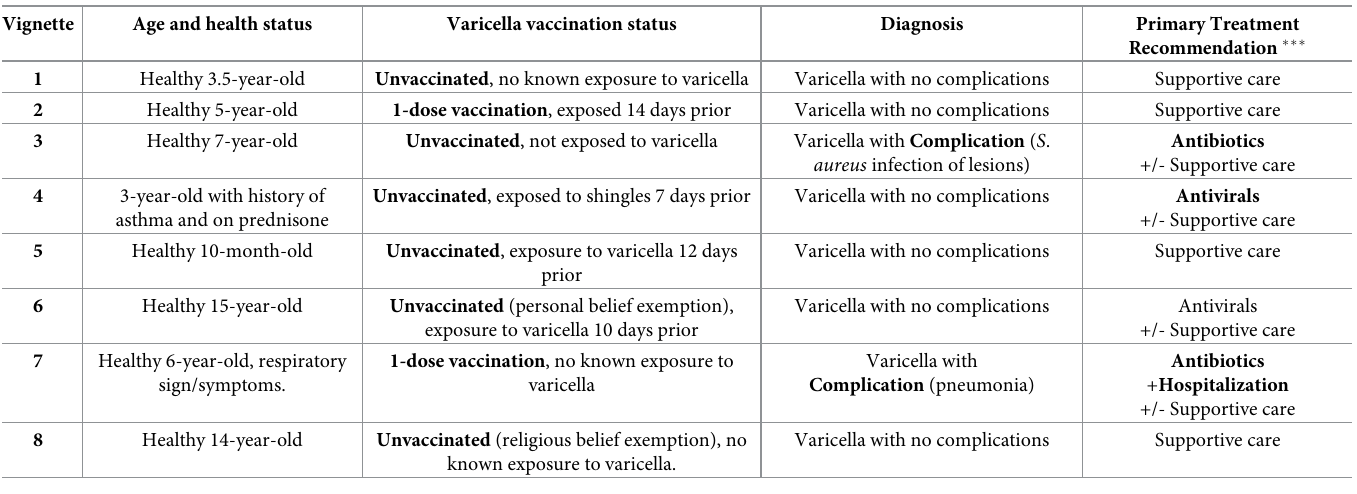
Table 2. Summary of case vignettes � .